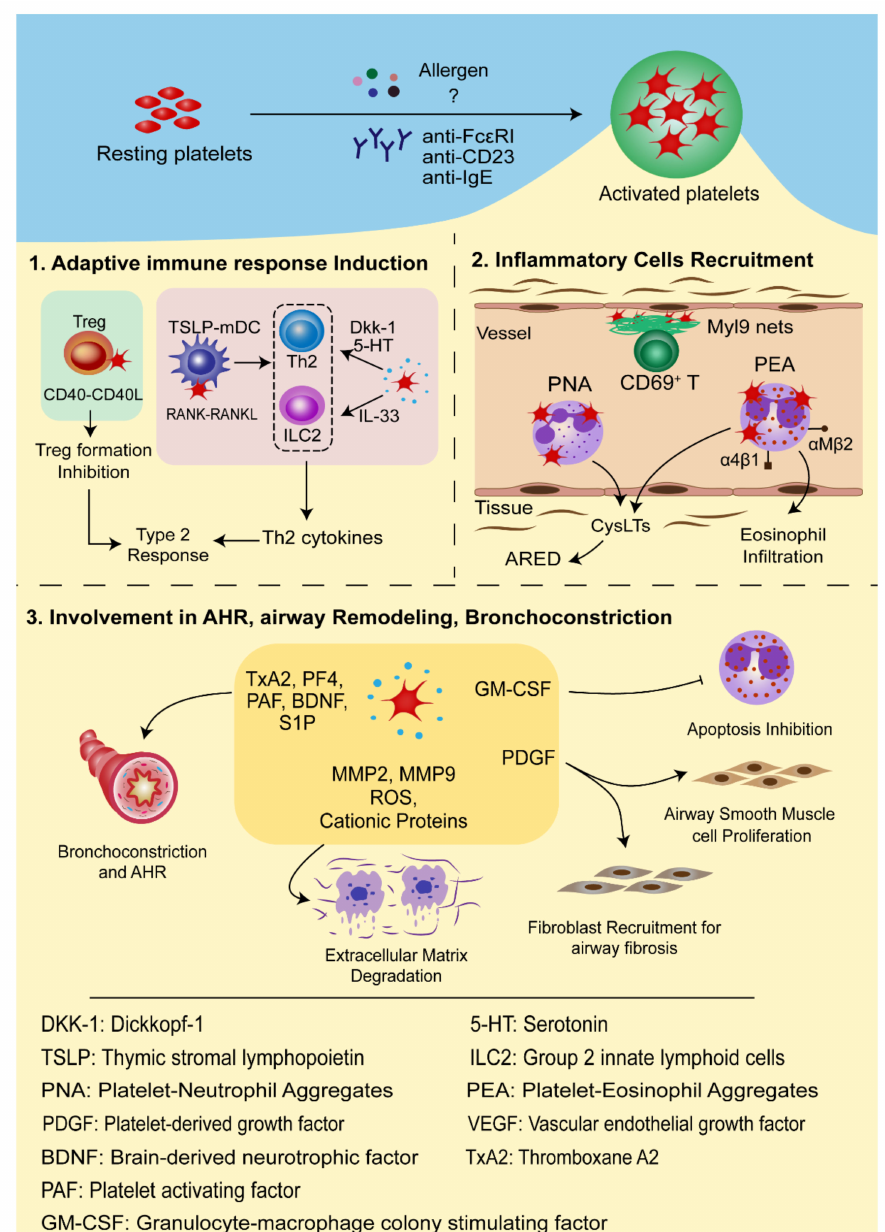
Figure 2. Involvement of platelets in the pathogenesis of allergic asthma. Environmental allergens, anti-IgE, and/or anti-IgE receptors (anti-Fc ε RI and anti-Fc ε RII/CD23) activate resting platelets. (1) Activated platelets secrete IL-33 that acts on ILC2, or Dkk-1 and 5-HT to promote naive T helper cells’ differentiation into Th2 effectors. Moreover, they can influence the activity of TSLP-stimulated mDCs in a RANK-RANKL-dependent pathway or inhibit regulatory T cells’ differentiation by overexpressing CD40L (CD154). (2) Activated platelets are involved in the recruitment of inflamma- tory cells. Platelets form aggregates with leukocytes through P-selectin-PSGL-1 interaction after allergens stimulation. The platelet-eosinophil aggregates (PEA) activate eosinophils and upregulate the expression of α M β 2 and α 4 β 1 integrins, through which PEA can adhere to the endothelial cells and migrate to the inflammatory sites. The platelet-neutrophil aggregates (PNA) activate the arachidonic acid pathway to generate CysLTs which contribute to ARED. The CD69-Myl9 system is a newly found mechanism mediating the infiltration of activated CD4 + CD69 + T cells into the inflamed tissue. (3) Activated platelets produce spasmogen, such as TxA2, PF4, PAF, BDNF, and S1P, to induce bronchial smooth muscle contraction as well as airway hyperresponsiveness. They also release MMP2, MMP9, cationic proteins, and ROS to cause degradation of extracellular